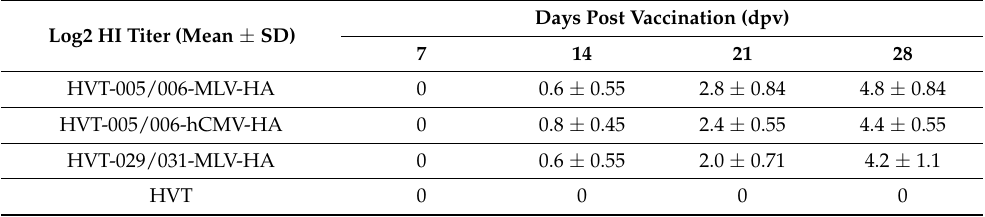
Table 3. Serum HA antibody levels in chickens vaccinated with the recombinant